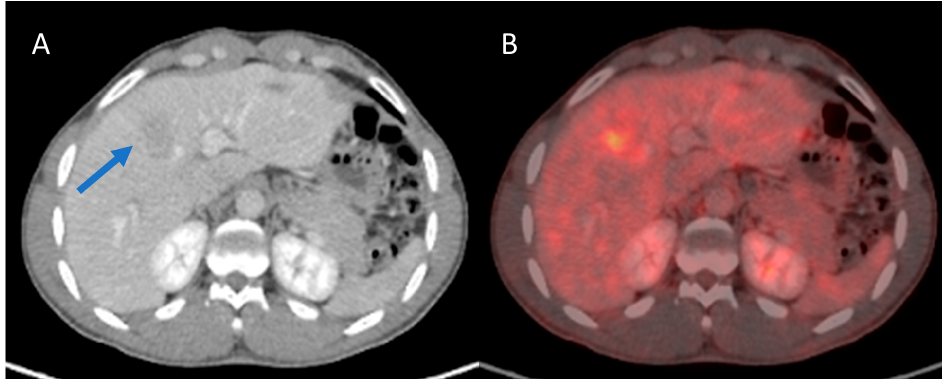
Figure 3. A hepatocellular carcinoma (HCC) of 44 mm was diagnosed in this patient (( A ), blue arrow) who had a positive surface hepatitis B virus antigen (HBV S Ag+). The lesion showed an intense FDG uptake ( B ) with SULpeak60 of 4.56 and TLRpeak60 of 2.10. The resection specimen evidenced a grade 3 HCC with microvascular invasion (MVI). The disease recurred two months after the surgery. FDG uptake has been correlated with the overall survival and/or progression-free sur- vival in an HCC in various stages and after different treatment approaches [33]. Cho et al. [10] reported that patients with a higher SUVmax on an HCC were more prone to relapse after a liver resection although differences between the groups were not significant. Similar results were obtained in the present study as even if TLRpeak60 was not a significant